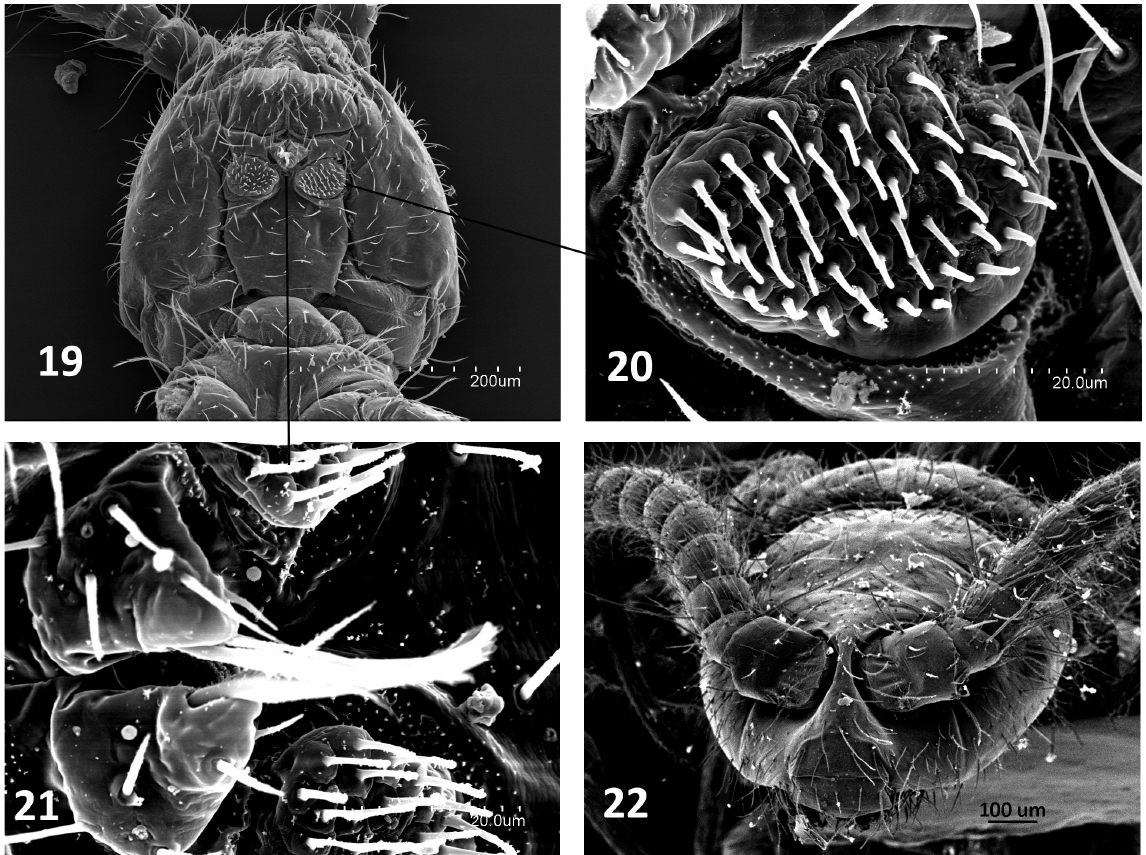
Figs 19–22. Campodea ( Dicampa ) catalana Denis, 1930. 19 . Head ventral side. 20 . Labial palp. 21 . Palpiform palps. 22 . Head frontal